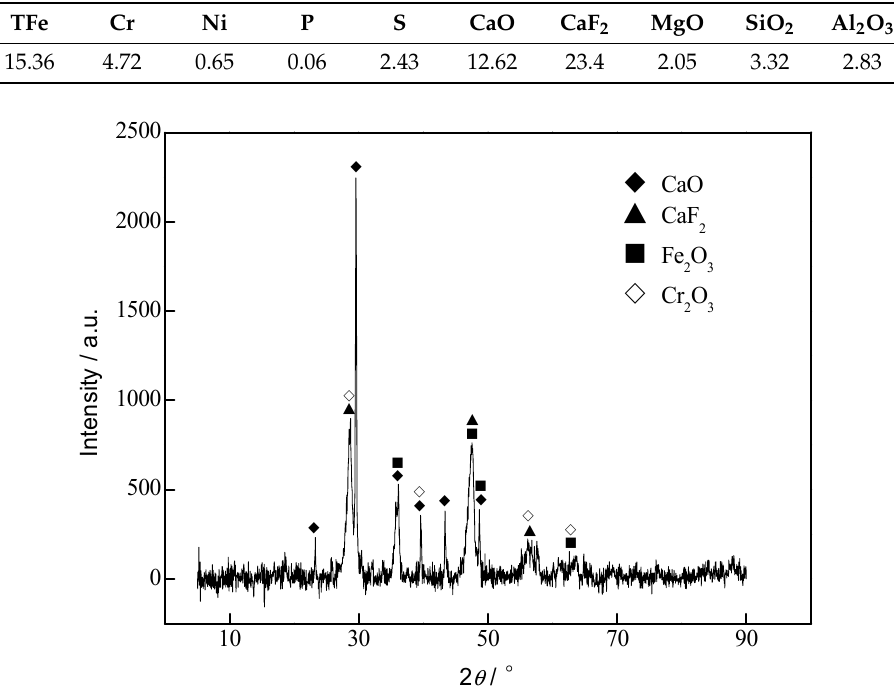
Table 2. Chemical composition of pickling sludge after drying at 105 °C (mass fraction, wt%).